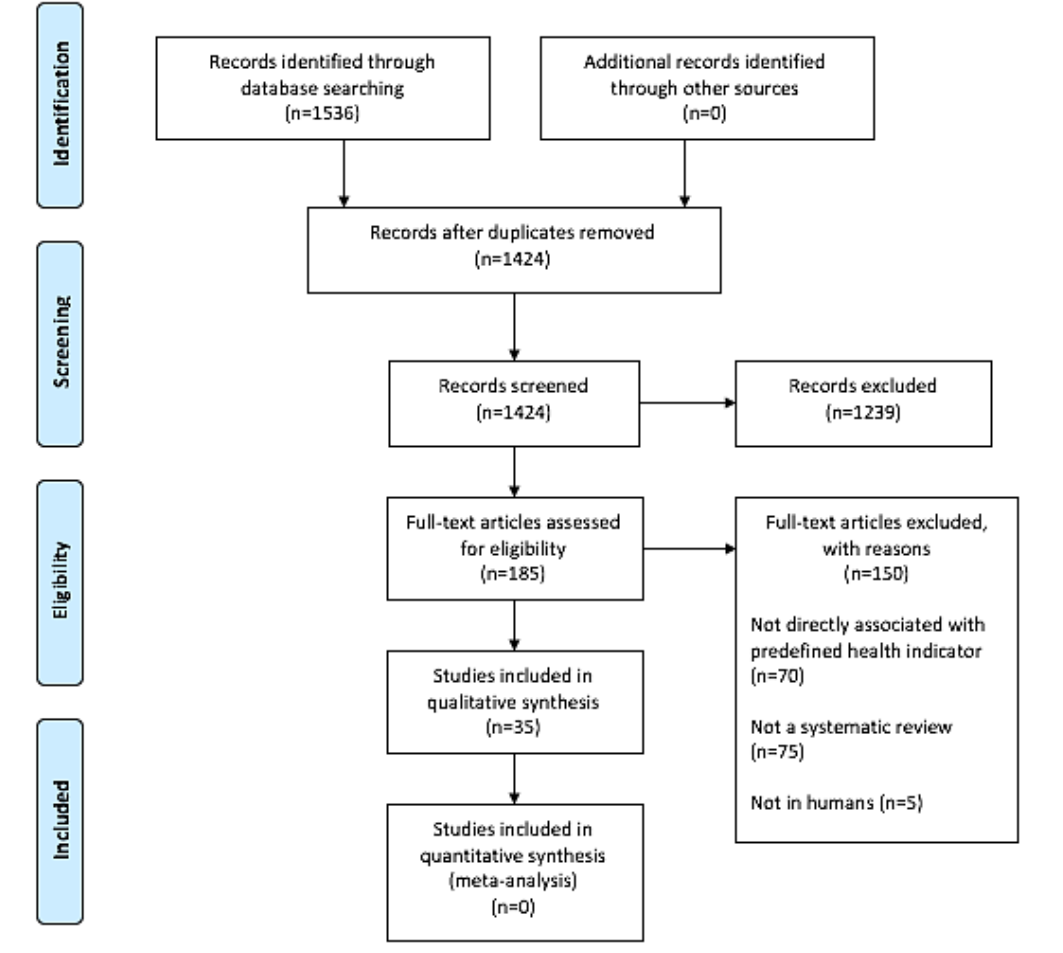
Figure 1. Flow chart of the different phases of article